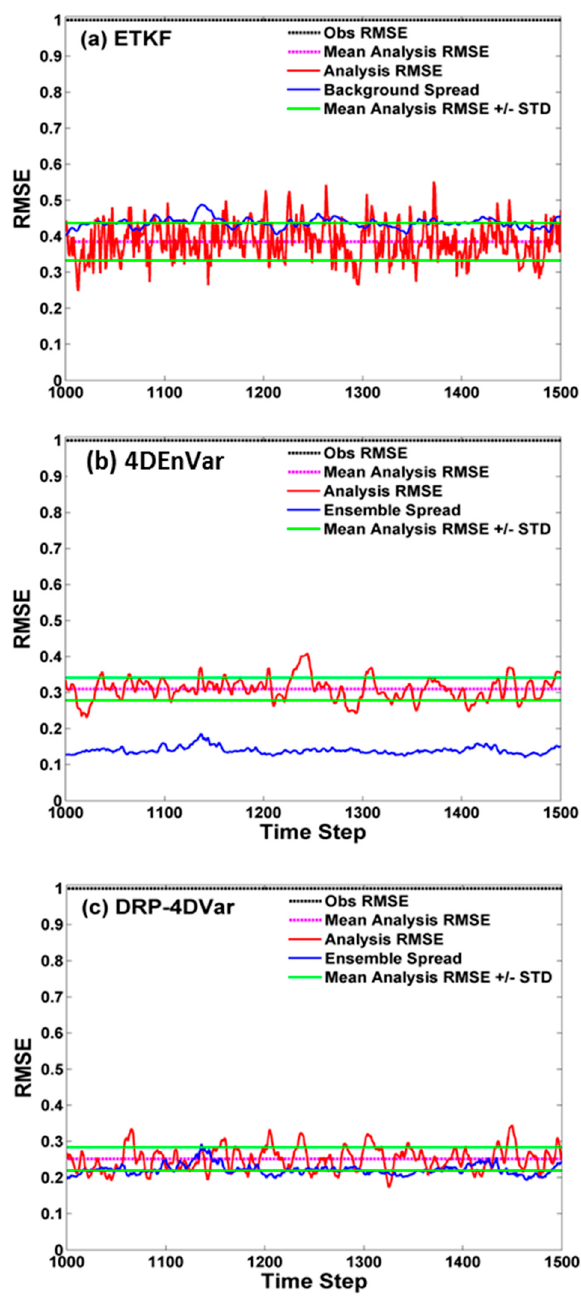
Figure 2. Time series of the analysis RMSE (red solid line) and background spread (blue solid line) of the ETKF experiment ( a ), the 4DEnVar experiment ( b ) and the DRP-4DVar ( c ) in Exp-1. Observation RMSEs (black dash line), mean analysis RMSEs (pink dash line), and Mean analysis RMSE +/ − standard deviation of analysis RMSEs (green solid line) are computed over last 500 time steps.